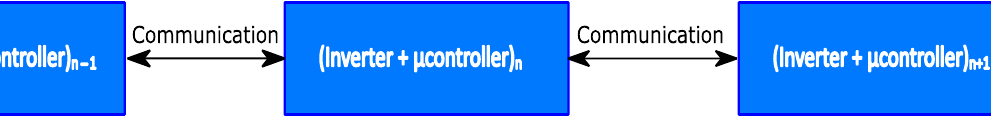
Figure 8. Communication pathways between microcontrollers.